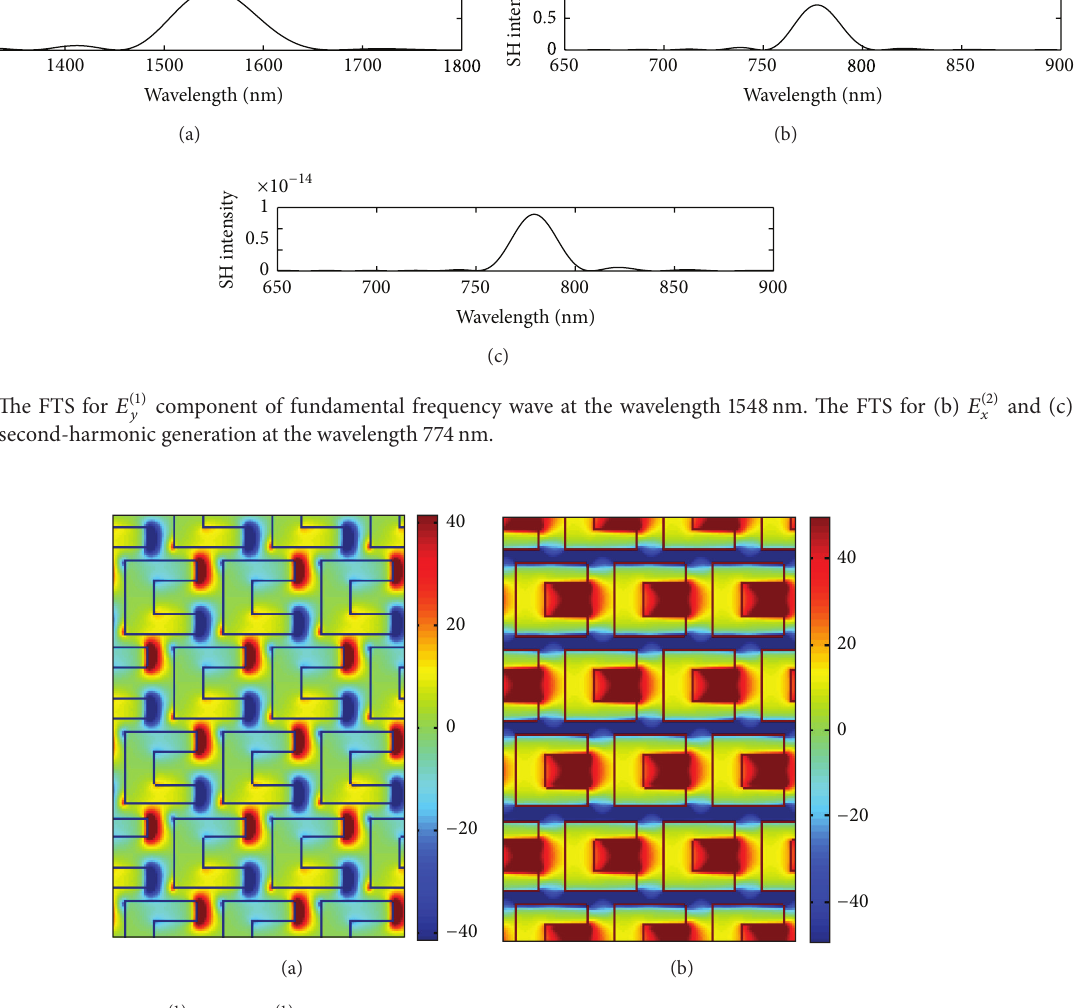
Figure 6: The electric field (a) 𝐸 (1) 𝑥 and (b) 𝐸 (1) 𝑦 distribution of fundamental frequency above the gold film region at wavelength 1548 nm,